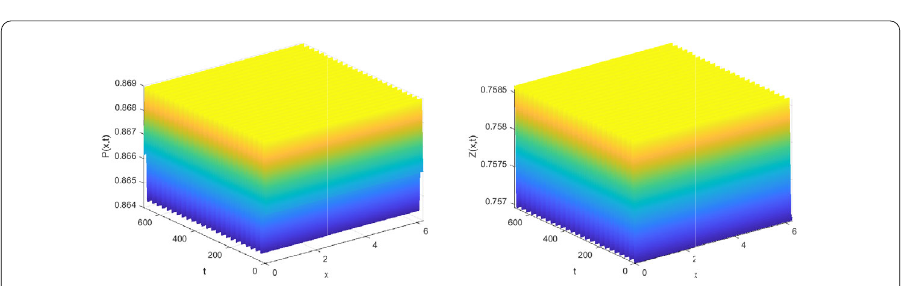
Figure 5 If τ = 3.45, the stable periodic solutions bifurcate from the equilibrium E ∗ = (0.866,0.757)